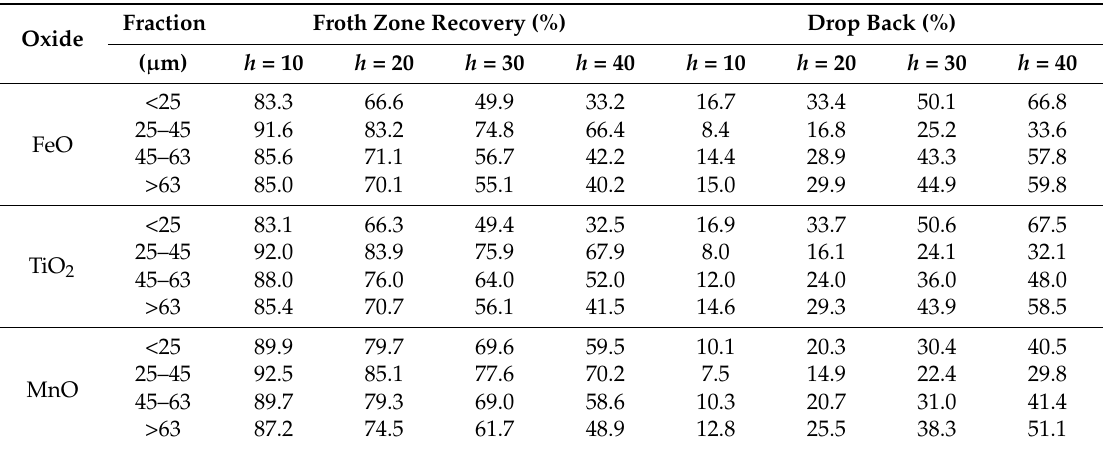
Table 7. Froth zone recovery by true flotation of the three different oxides of the four size fractions for four froth heights